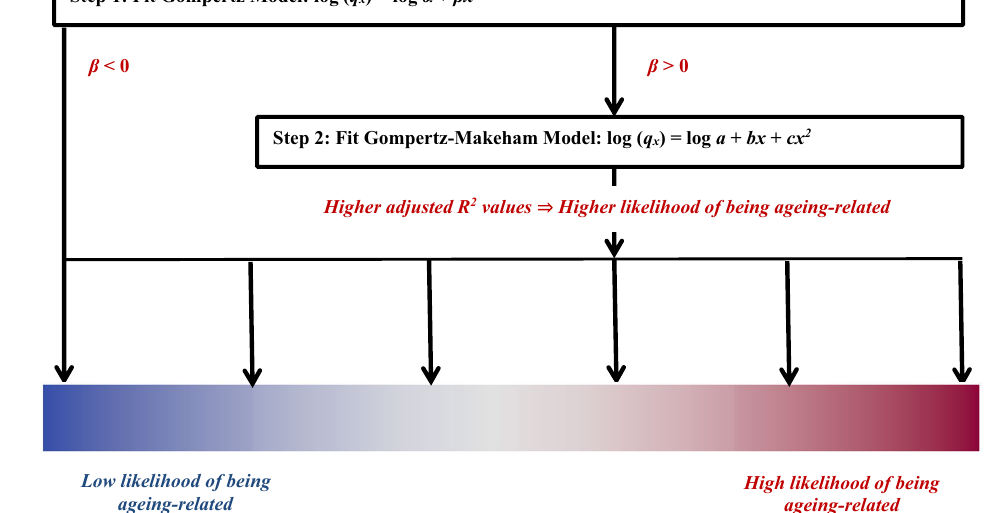
Figure 1. Algorithm for determining the likelihood that a disease is ageing-related. This depends on β, the age coefficient of the Gompertz model and the adjusted R 2 of the Gompertz–Makeham model for each disease. q x is the age-specific rate of disease onset at age x . α, β, a, b, and c are